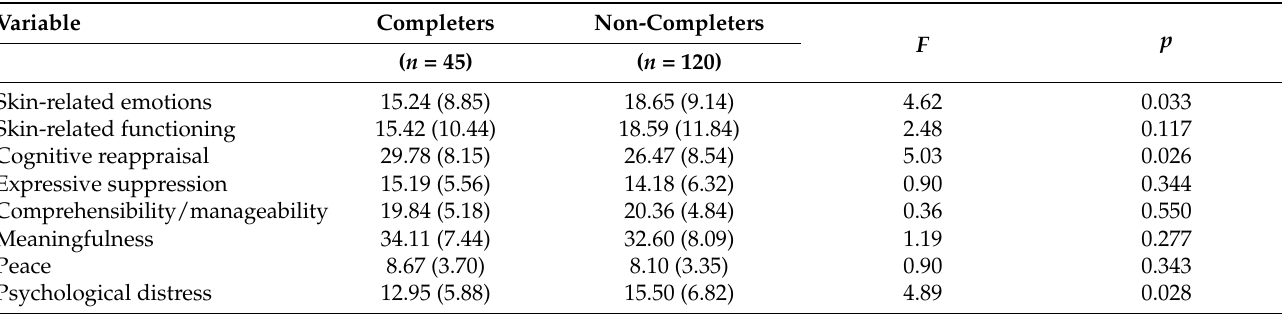
Table 3. Means, standard deviations, and multivariate analyses of variance of outcome variables in completers and